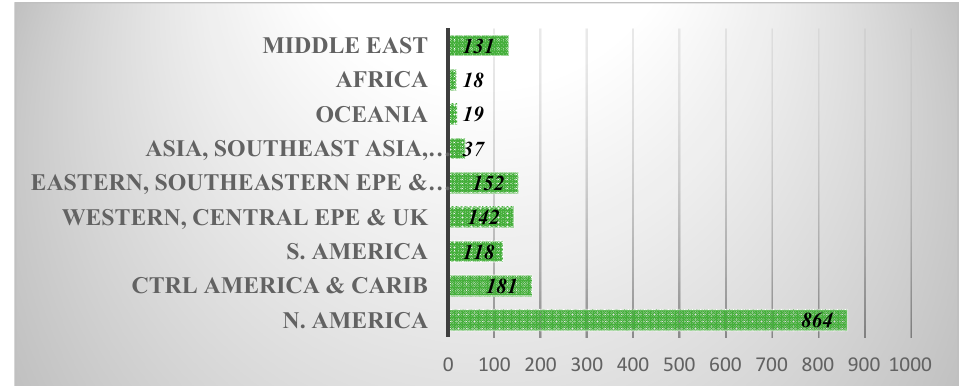
Figure 1. Aggregate locations of archaeologists’ reported experiences with looting.